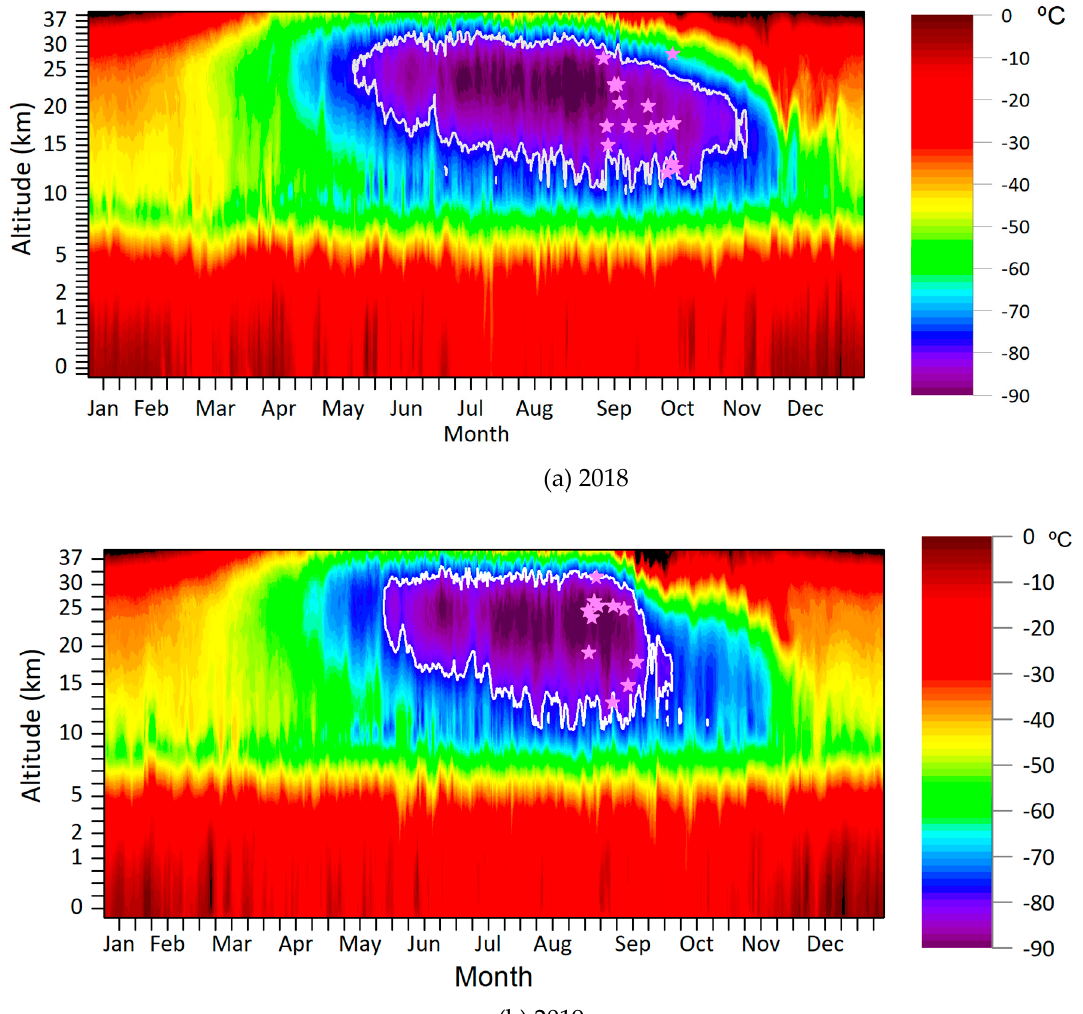
Figure 8. Temperatures profiles over Belgrano II obtained with ERA5 data reanalysis from the global meteorological model European Centre for Medium Range Weather Forecasts (ECMWF) ( a ) during 2018; and ( b ) during 2019. White contour outlines the altitudes and time of temperatures lower than − 78 ◦ C (195 K), where Polar Stratospheric Clouds usually may form. Pink stars correspond to the PSCs detected in this work.